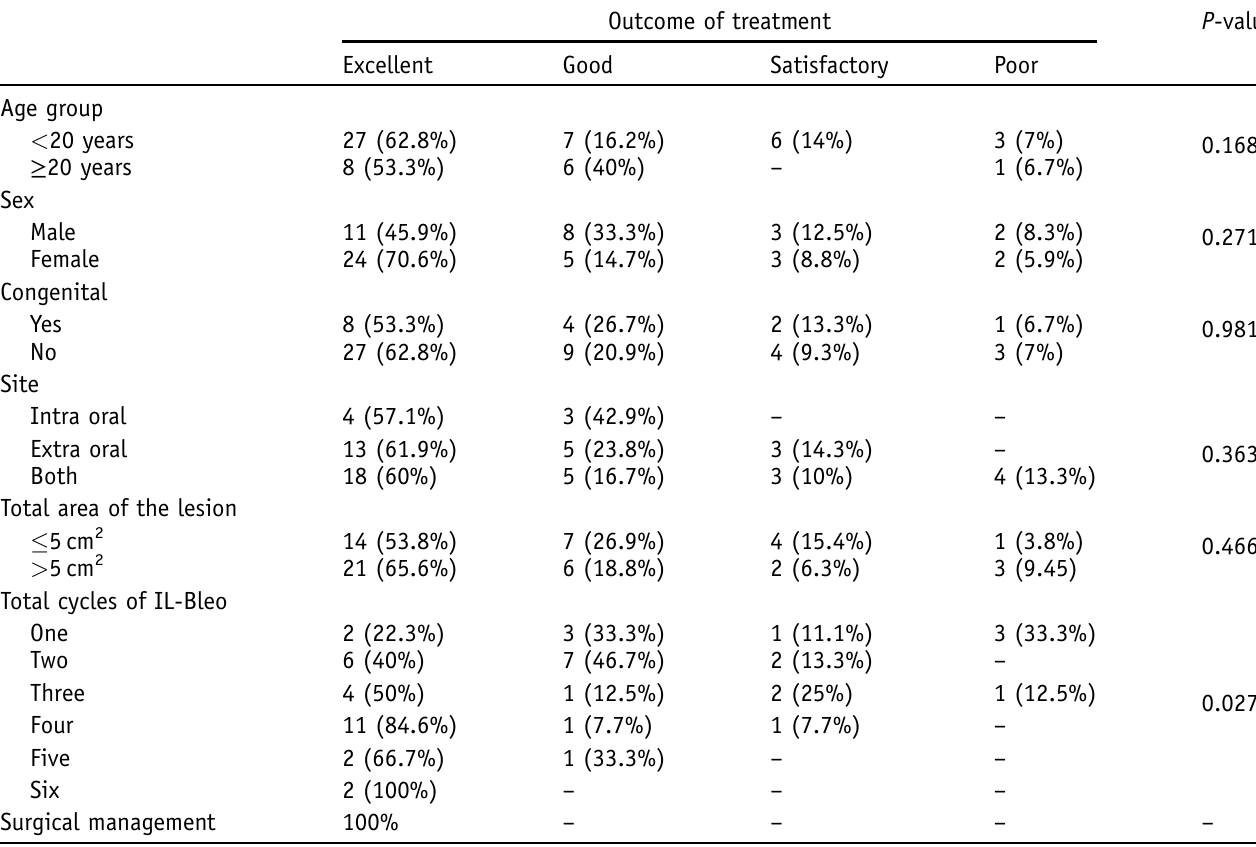
Table III. Outcome of treatment of hemangioma against different associated